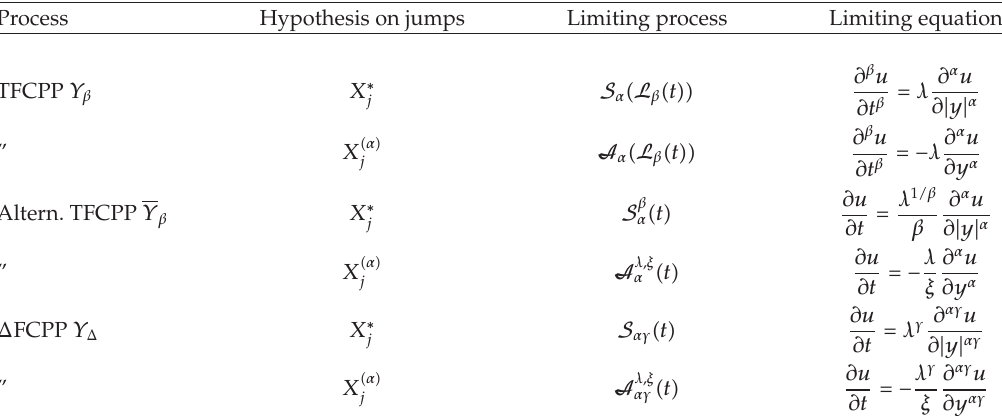
Table 2: Main results in asymptotic